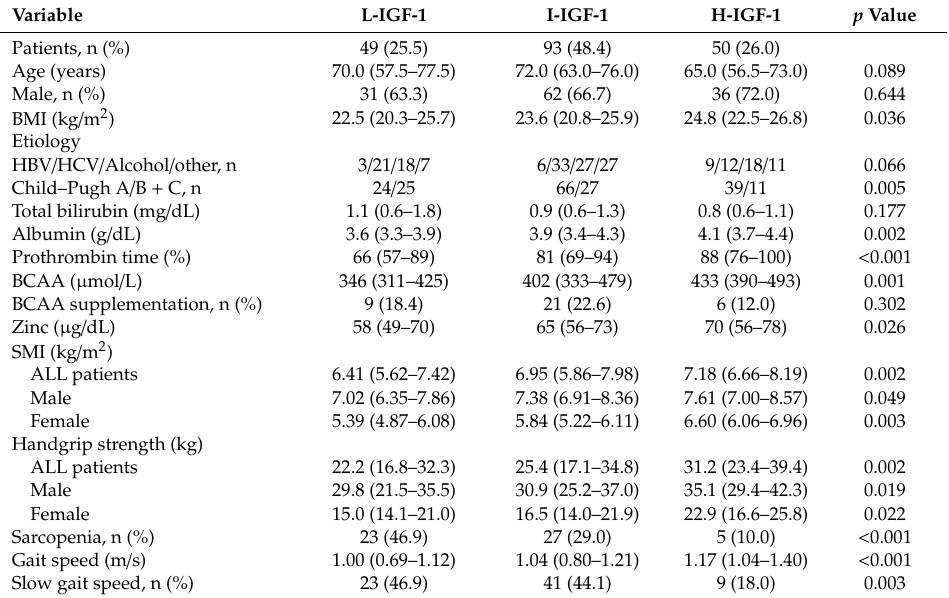
Table 4. Characteristics of the three groups based on serum IGF-1 levels.